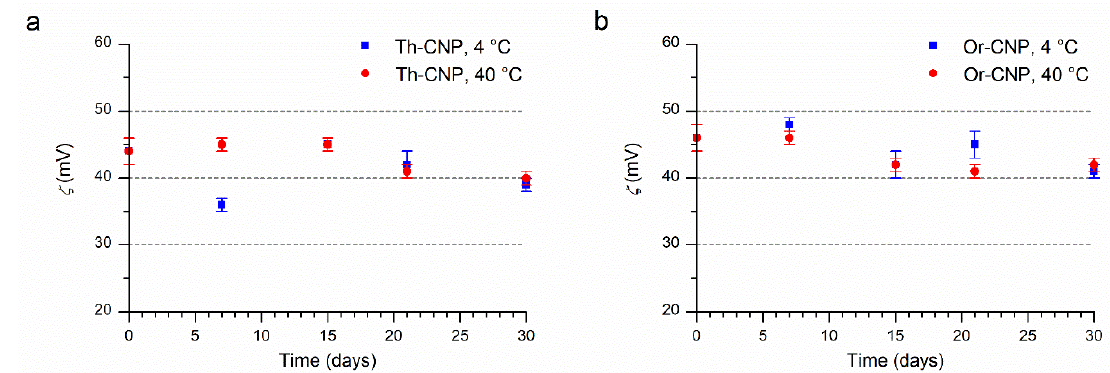
Figure 3. Zeta potential over time at 4 ◦ C (square) and 40 ◦ C (circle) of ( a ) Th-CNPs, ( b ) Or-CNPs. nanoparticles, the different behavior of the two systems was highlighted. For Th-CNPs, as shown in Figure 4, the retention decrease of thyme essential oil occurs gradually up to 21 days for both samples kept at 4 ◦ C and 40 ◦ C, reaching the 95% retention value. At 30 days, an EO retention of 91% and 83% is observed for samples kept at 4 ◦ C and 40 ◦ C, respectively.